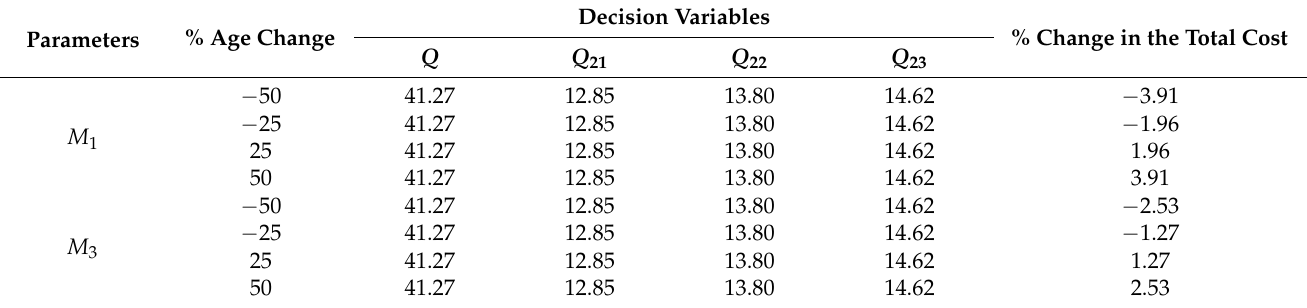
Table A3. Sensitivity analysis for manufacturing cost of manufacturer and